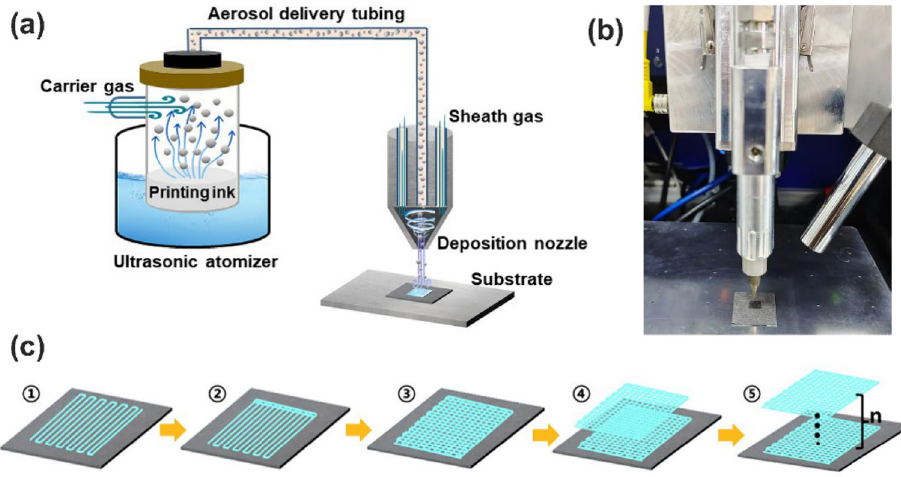
Figure 9. ( a ) Schematic diagram of aerosol jet printing (Microsoft Office Hone and Student 2019-zh-cn https:// www. micro softs tore. com. cn/ softw are/ office). ( b ) Optical image of the aerosol printer in the process of printing electrolyte. ( c ) Printing process of the ultrathin electrolyte (Microsoft Office Hone and Student 2019-zh-cn https:// www. micro softs tore. com. cn/ softw are/